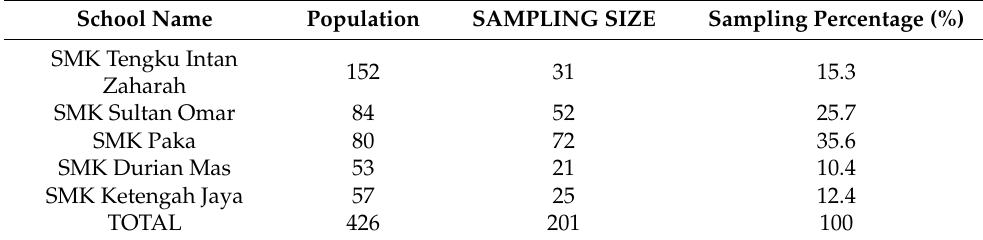
Table 1. Number of study population and sample.